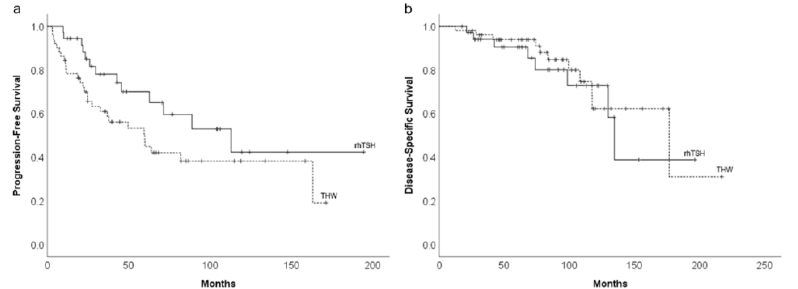
Figure 1. Kaplan–Meier plots of progression-free survival (PFS) ( a ) and disease-specific survival (DSS) ( b ) in patients prepared for RAI treatment by either THW ( n = 51) or rhTSH stimulation ( n = 37). There was no significant difference in terms of PFS and DSS between the two study groups.